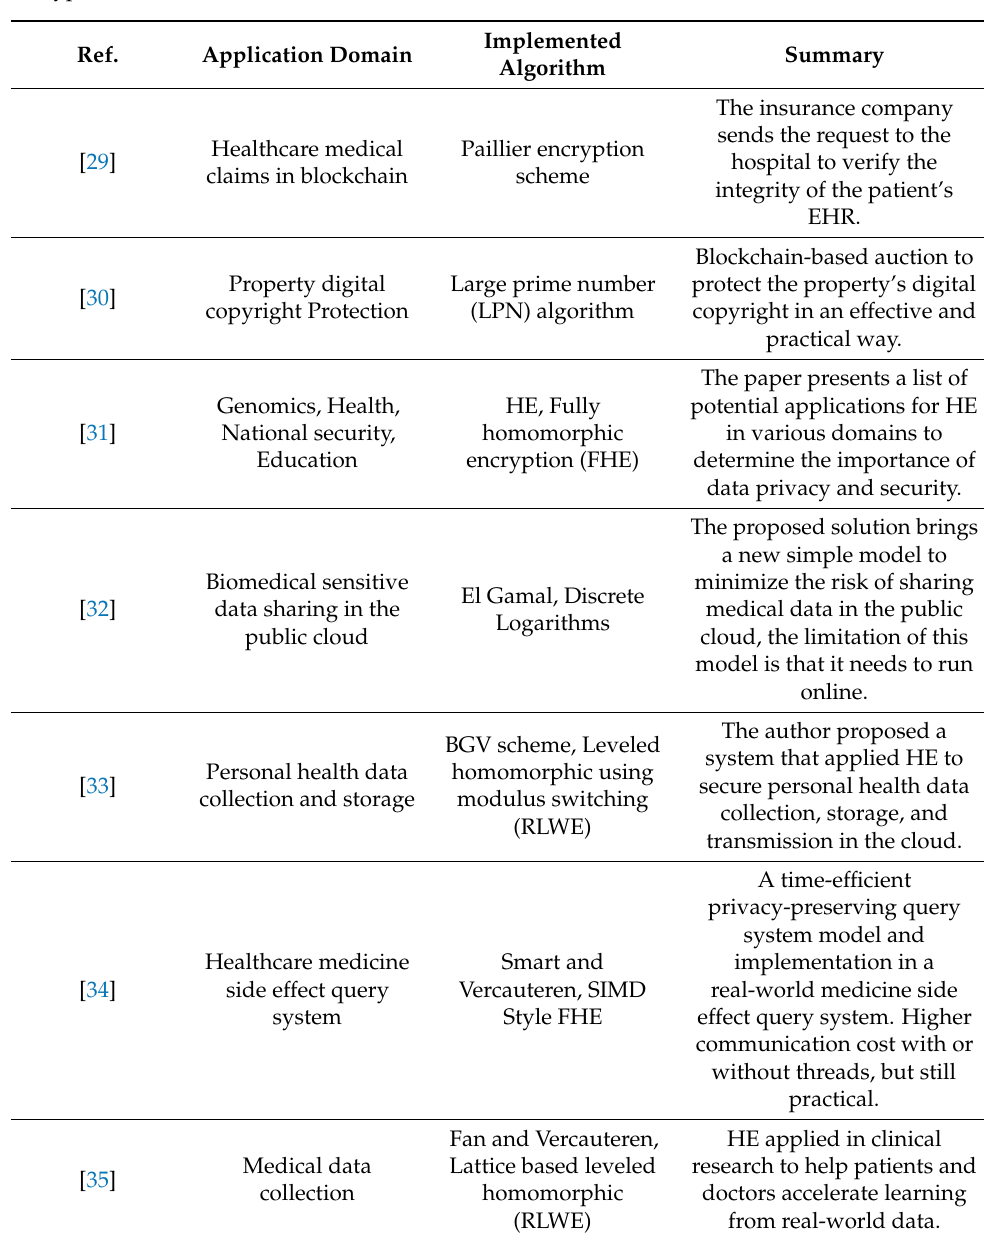
Table 2. The comparison of the implementation of blockchain technology and homomorphic